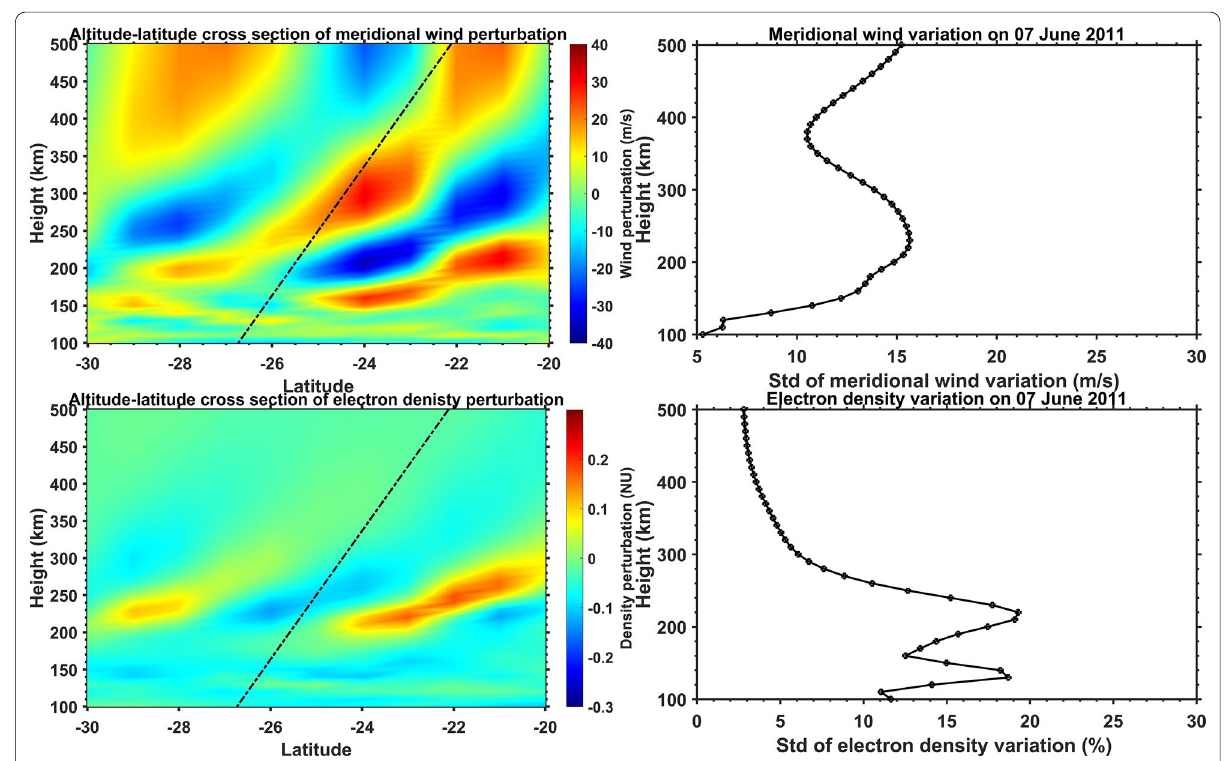
Fig. 10 Same as Fig. 9, but for a typical day (07 June 2018) at 15:42 LT in SH